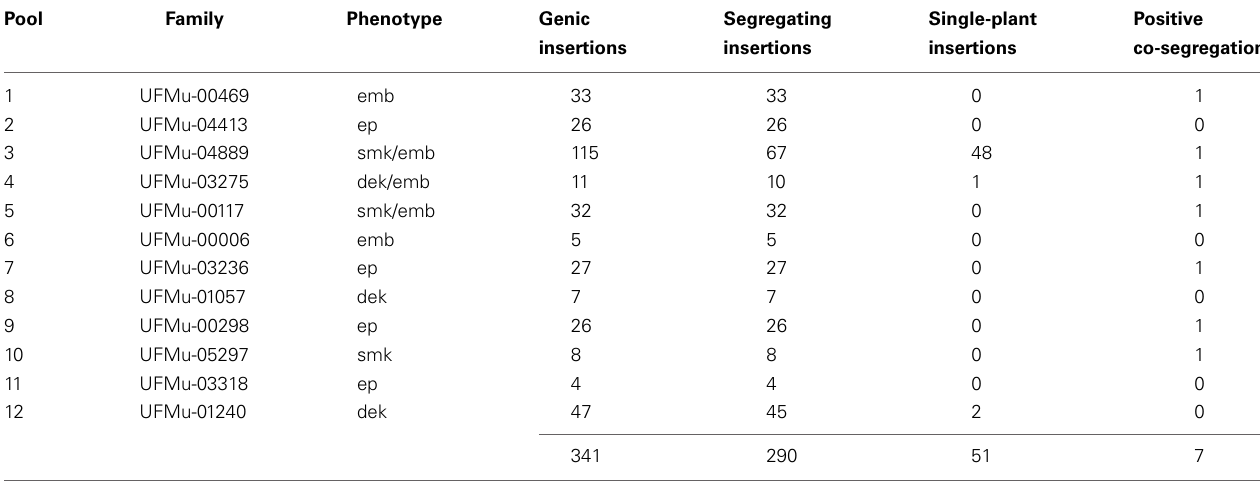
Table 1 | Sequencing results from forward-genetics Mu-seq